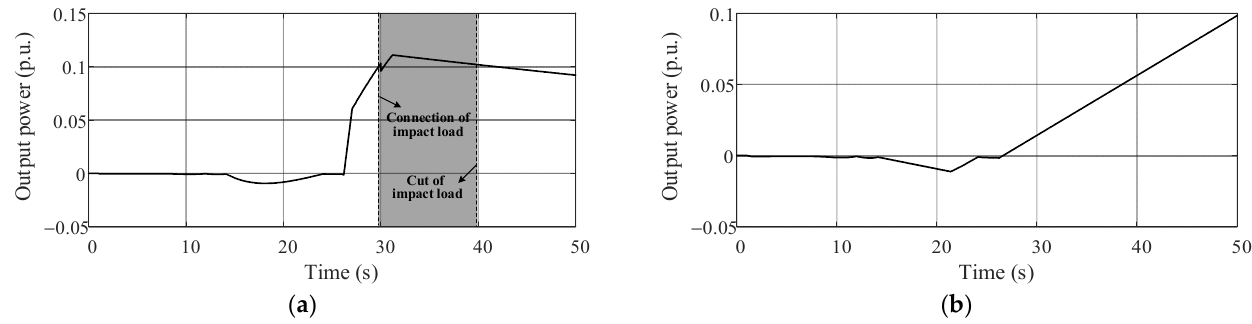
Figure 18. The output power of LIB and SC. ( a ) Output power of LIB. ( b ) Output power of SC.